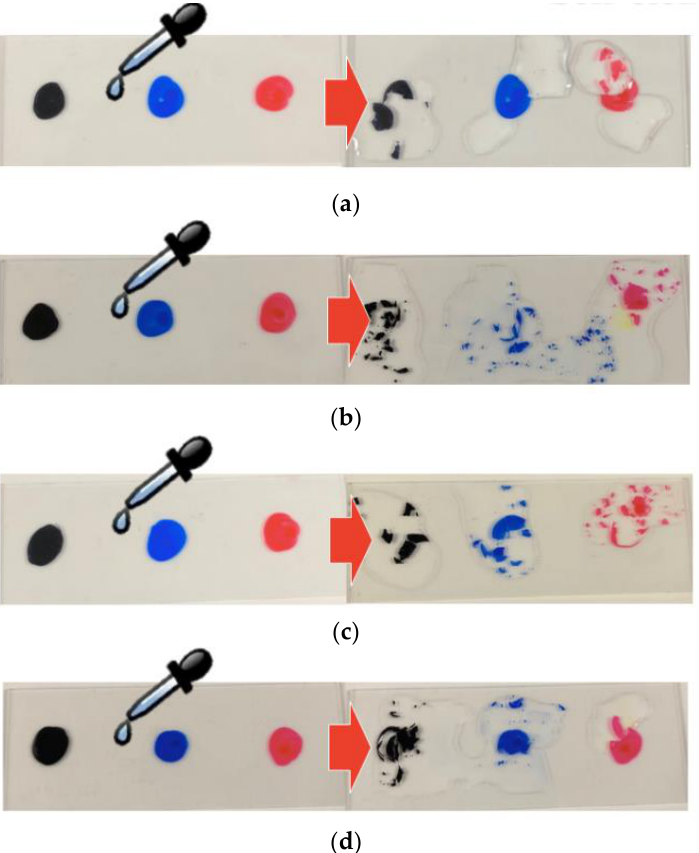
Figure 2. Anti-pollution characteristics according to the number of coating and annealing: ( a ) natu- ral drying, ( b ) one step, ( c ) two steps, and ( d ) three steps. drying, ( b ) one step, ( c ) two steps, and ( d ) three